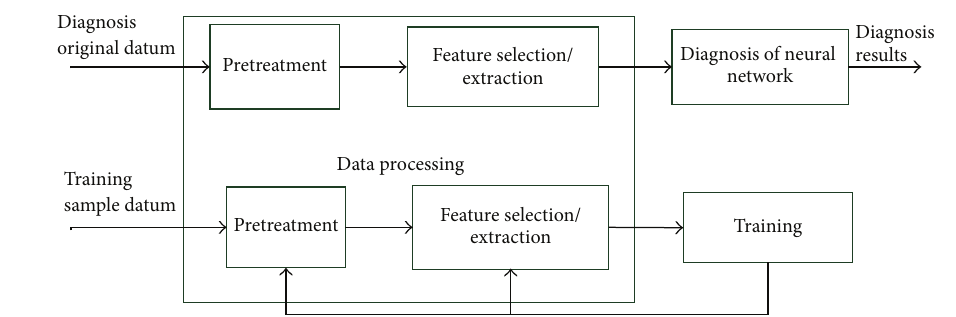
Figure 3: Structure of neural network fault diagnosis